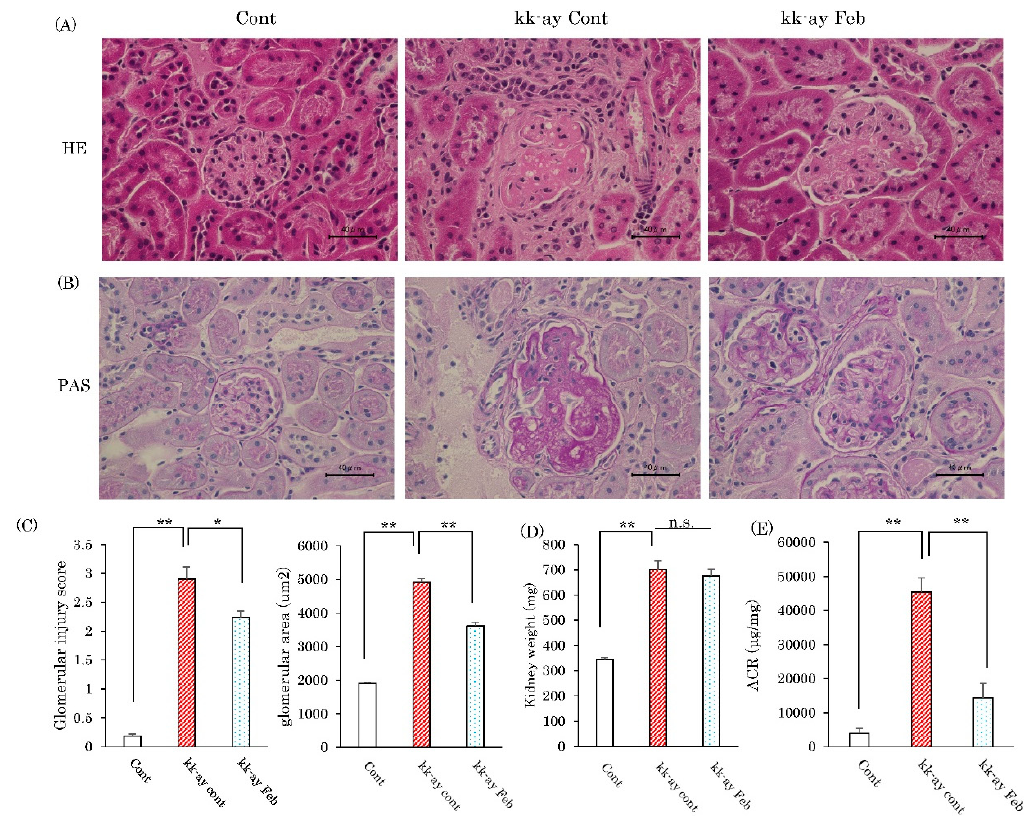
Figure 2. Febuxostat administered for prevention of glomerular sclerosis. ( A ) Hematoxylin–Eosin (HE) staining of kidney fractions. Scale bar = 40 µ m. ( B ) Peroxide acid-Schi ff (PAS) staining of kidney fractions. Scale bar = 40 µ m. ( C ) Glomerular sclerosis score and glomerular area were calculated using image J. ( D ) Kidney weights and ( E ) the urinary albumin to creatinine ratio was measured at 20 weeks. Data are means ± SE. * p < 0.05, ** p < 0.001. n = 8 for control group, n = 10 for KK-Ay mice without febuxostat group and n = 8 for KK-Ay mice with febuxostat group. 2.3. E ff ects of Febuxostat on the Renal Expression Levels of Inflammatory